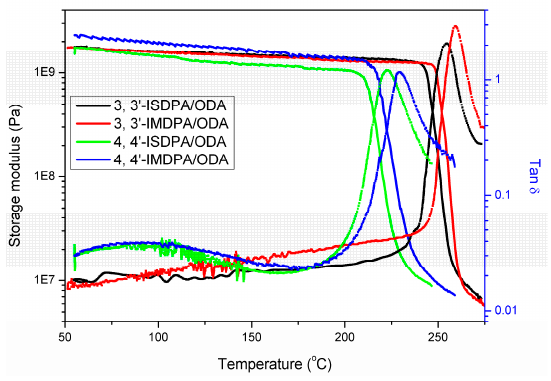
Figure 6. Representative DMTA curves of isohexides-derived PEIs.